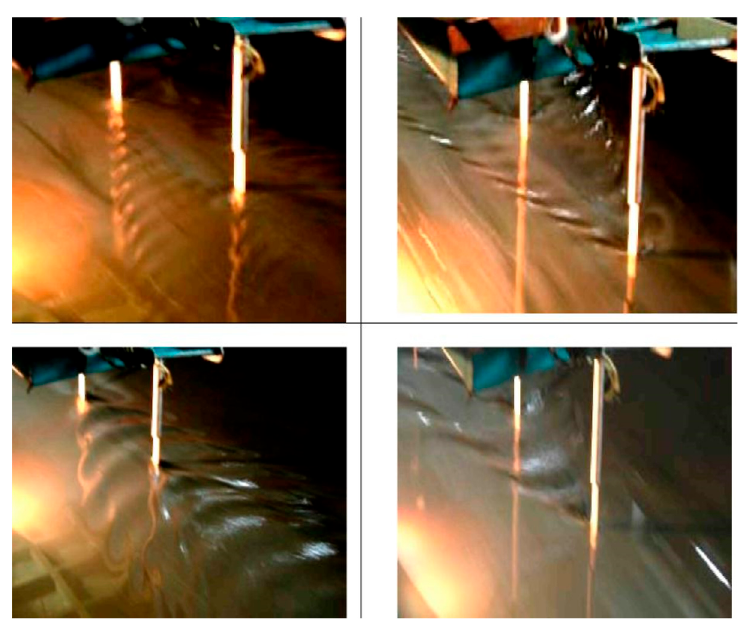
Figure 3. Wave formation during movement of tandem struts (on the left—forward motion with a blunt end on the right—with a sharp end, L = 0.914 m, upper Fr = 0.161, lower Fr = 0.356).